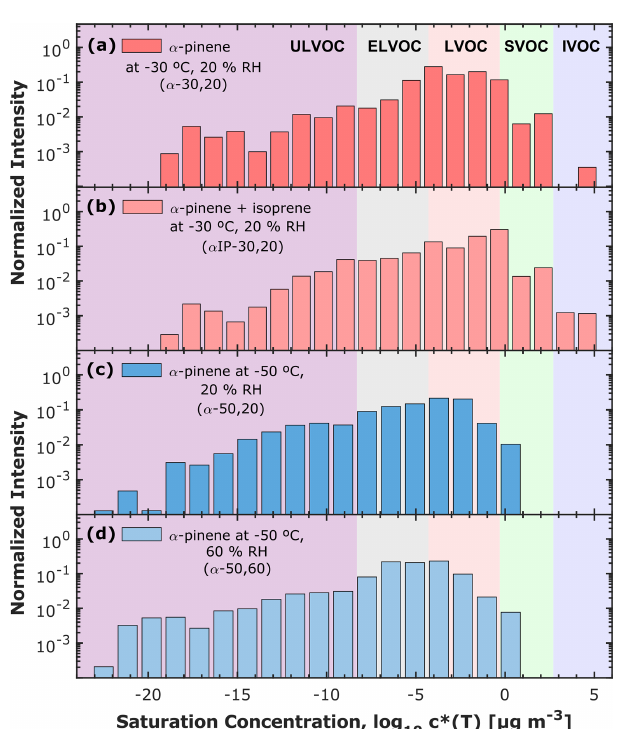
Figure 5. TD-DMA volatility distribution of the measured ox- idation products in the particle phase for four different experi- ments: (a) α -pinene at − 30 ◦ C and 20% RH ( α -30,20), (b) α - pinene + isoprene at − 30 ◦ C and 20% RH ( α IP-30,20), (c) α - pinene at − 50 ◦ C and 20% RH ( α -50,20), and (d) α -pinene at − 50 ◦ C and 60% RH ( α -50,60). Every individual volatility bin in- cludes the sum of the intensity for the oxidation products normal- ized by the total signal in each system. Every individual volatility bin is defined at 300K, shifted, and widened according to their cor- responding temperature. The color bands in the background indicate the volatility regimes as in Donahue et al. (2012) and in Schervish and Donahue (2020). The normalized intensity is dimensionless. Nevertheless, it should be noted that the particle-phase signal is given in normalized counts per second integrated over the evapo- ration time (ncps/s).